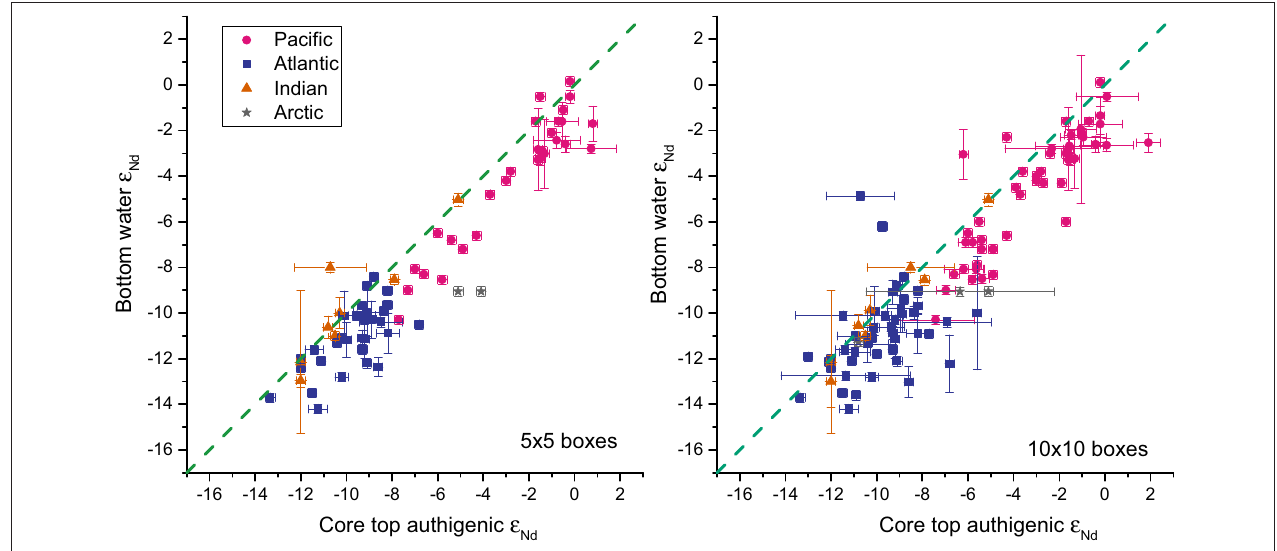
FIGURE 5 | Compiled ε Nd from core top authigenic phases and Bottom water. These data are compiled as averages from all published data within 5 ◦ and 10 ◦ boxes (ranges within these boxes are shown as error bars). This data compilation is available upon request, or find a similar compilation from Tachikawa et al.